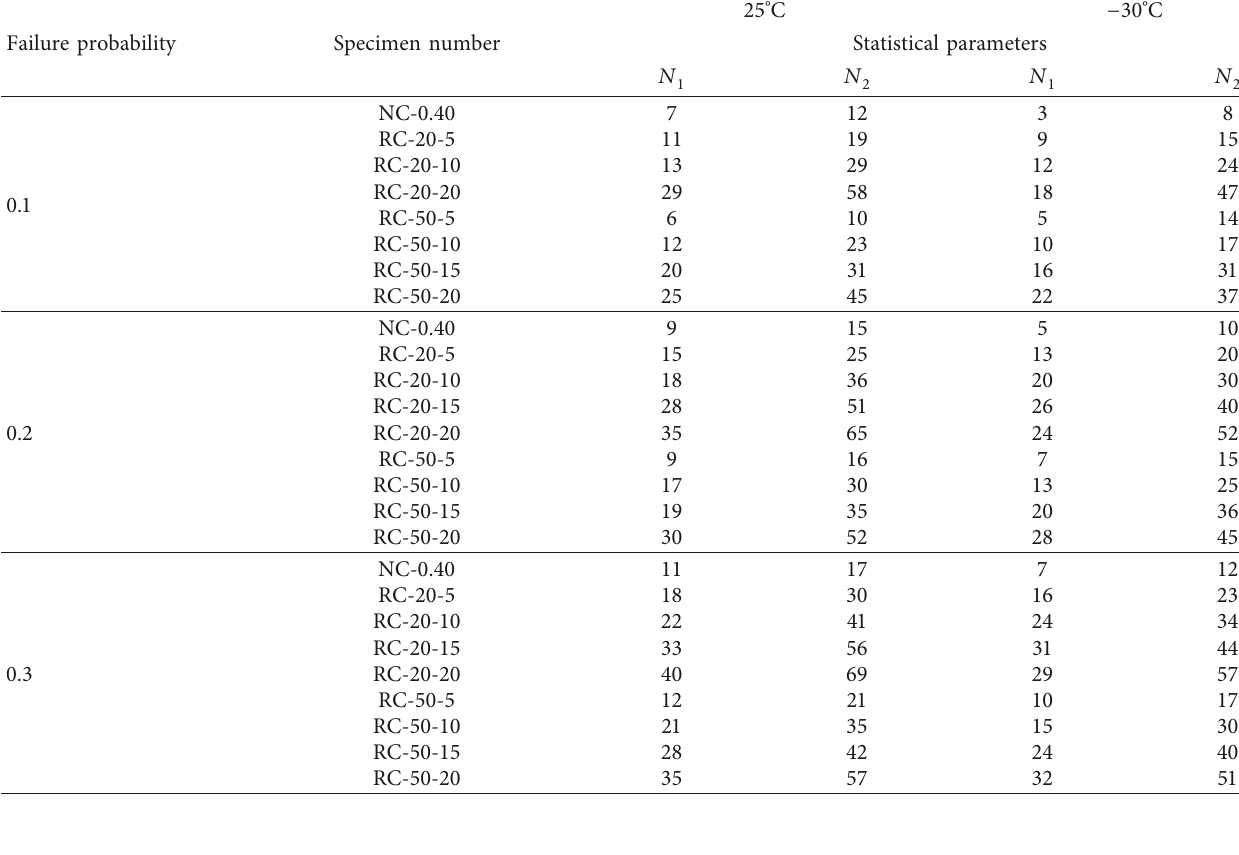
Table 11: Impact times of the rubber concrete specimens under different failure probability